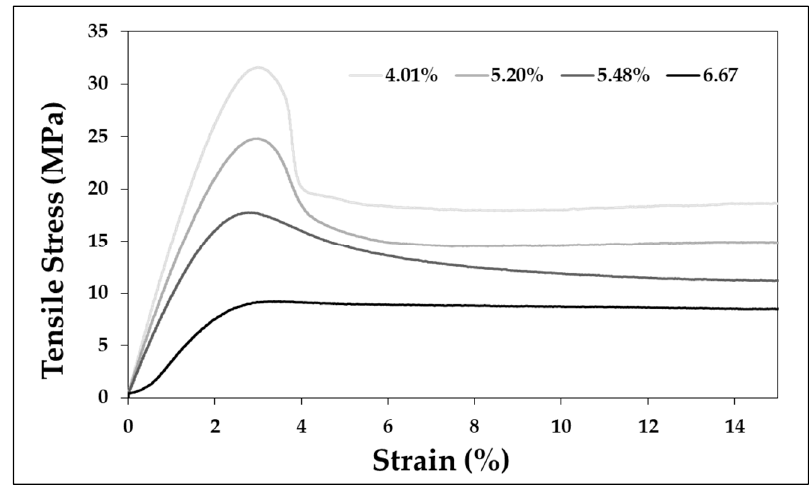
Figure 12. Stress–strain curve change of APET based on saturation time.